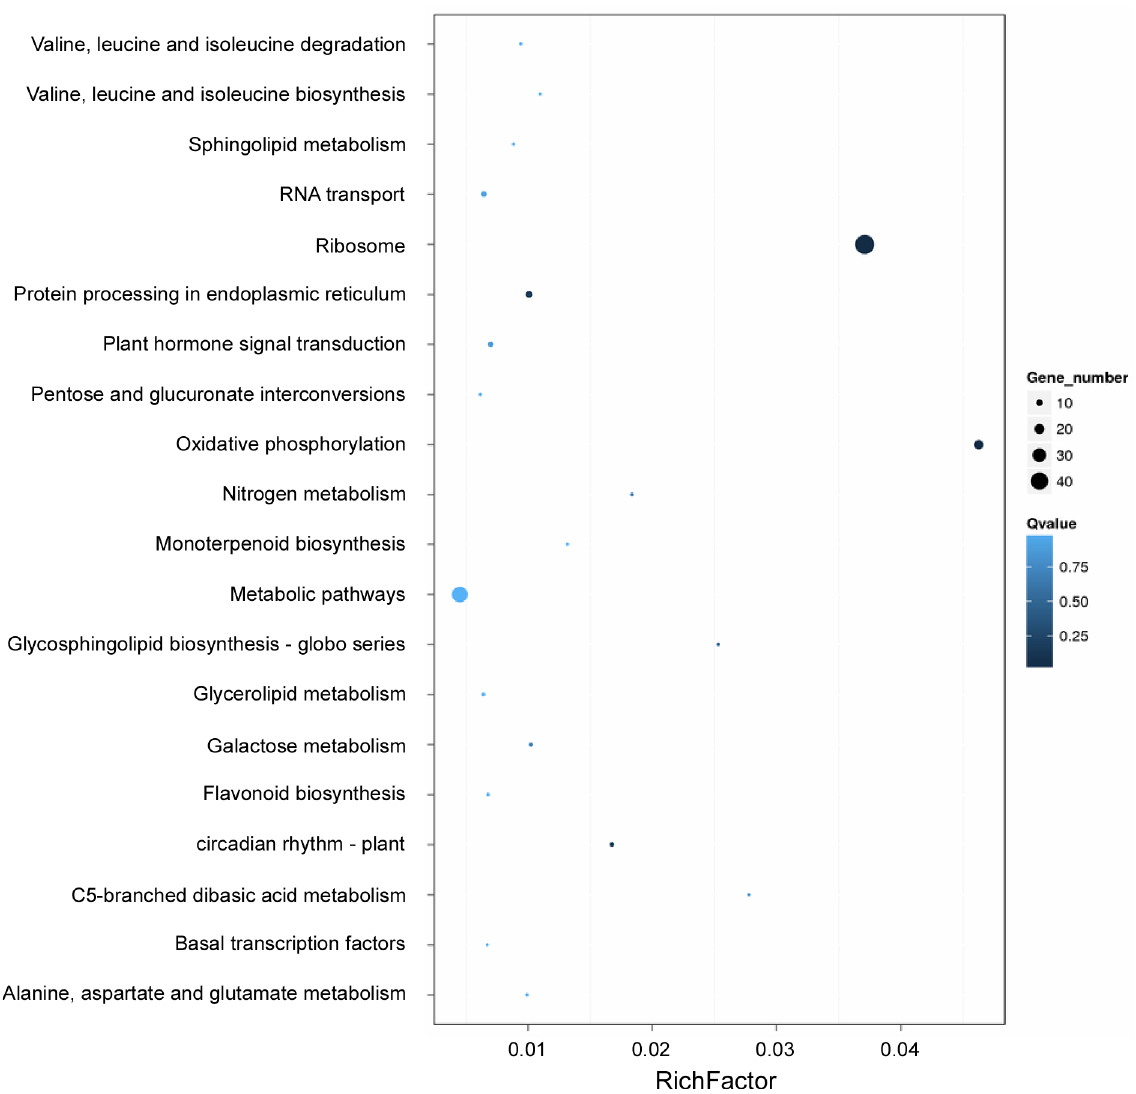
Fig 2. Pathways functionally enriched with DEGs. X-axis represents the enrichment factor. Y-axis represents the pathway name. Coloring correlates with the q-value. The lower the q-value, the more significant the enrichment. Point size correlates with the number of